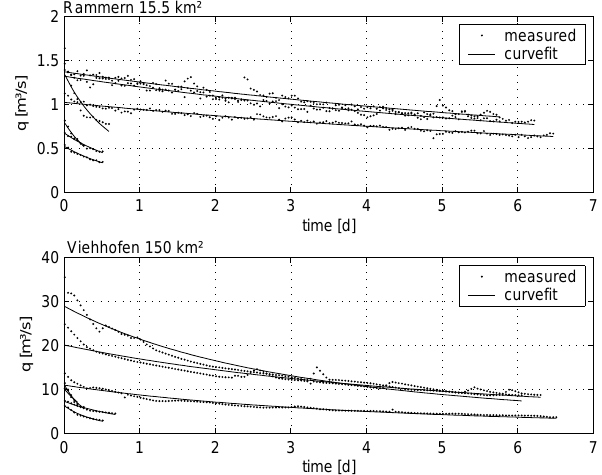
Fig. 9. Recession curves for the rainfall runoff evens measured 1997 (every forth measured point is plotted) for Rammern and Viehhofen: nonlinear